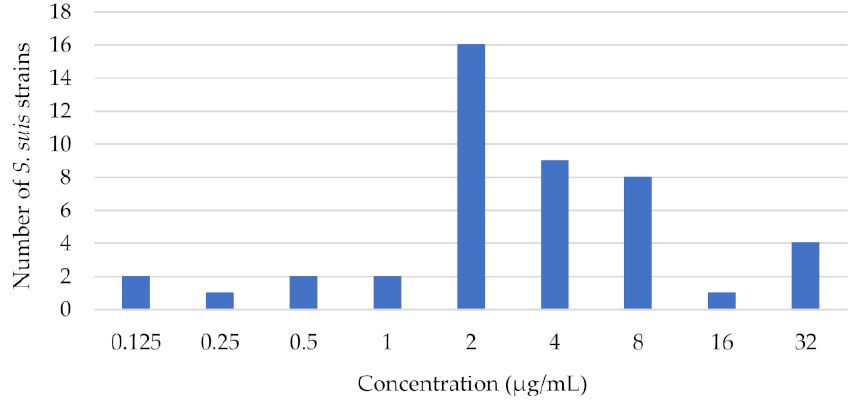
Figure 2. Minimum inhibitory concentration distribution of florfenicol against S. suis in Hungary between 2018 and 2021 (n = 45).